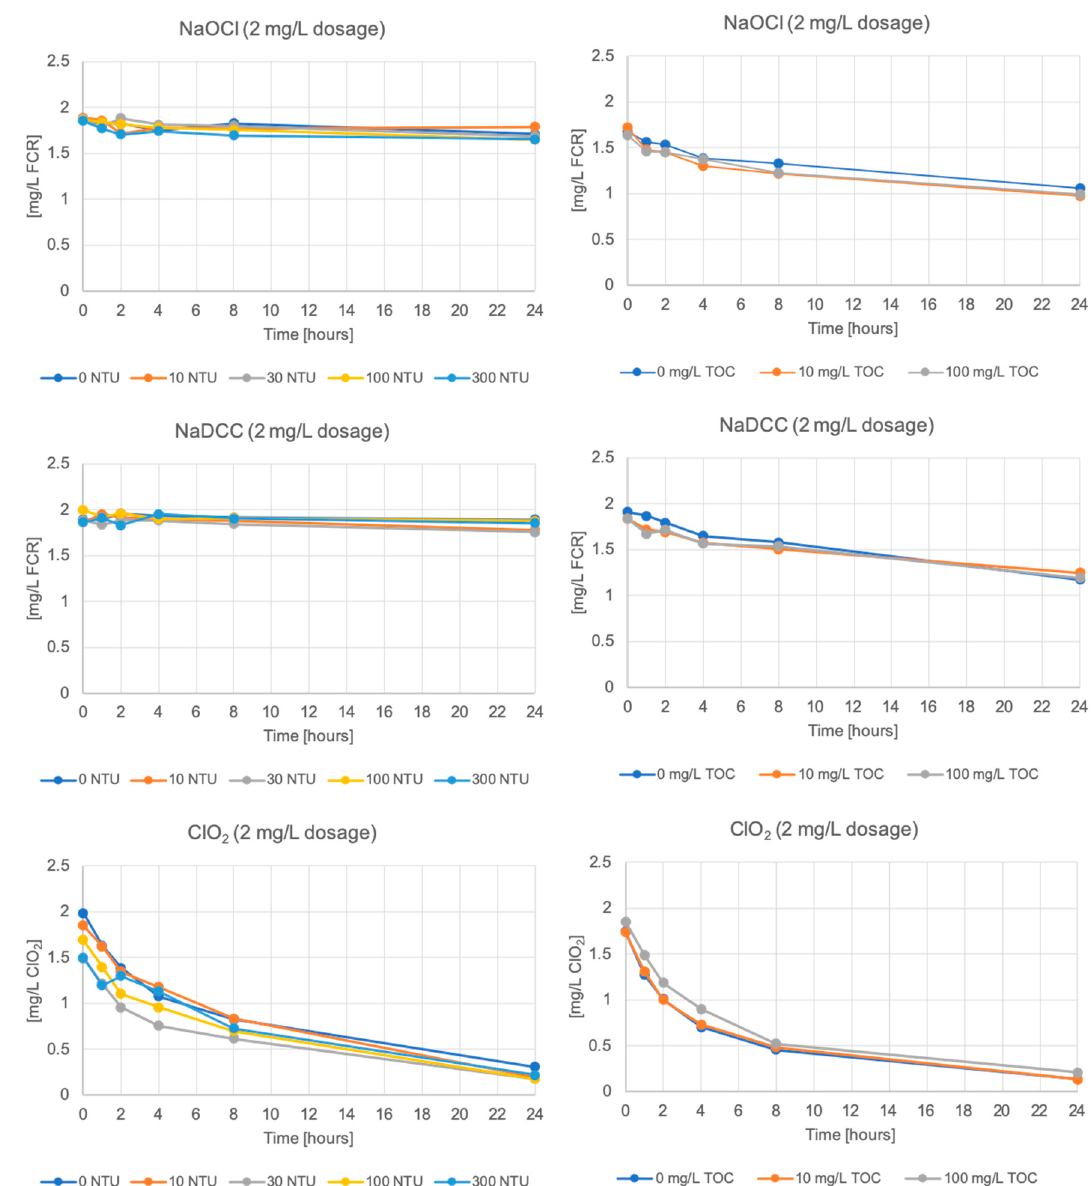
Figure 3. Disinfectant residual concentration over time at varying turbidity from clay (left) and varying added TOC (right) for the 2 mg/L dosage.